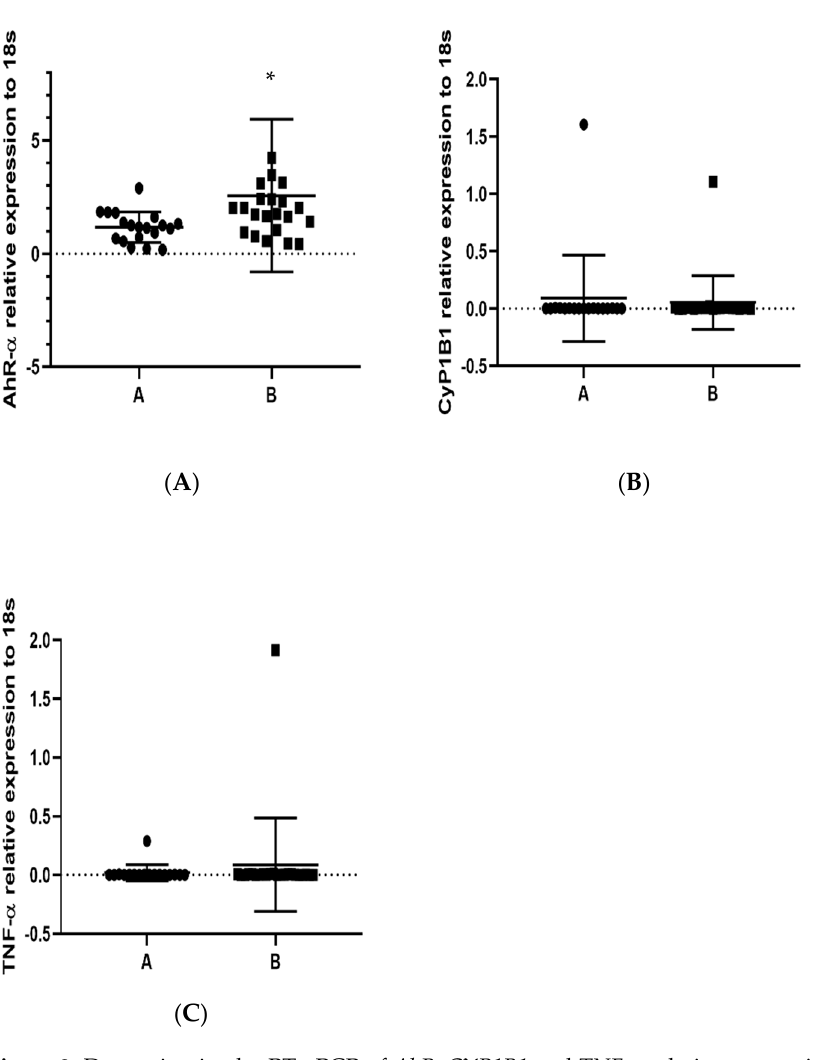
Figure 2. Determination by RT-qPCR of AhR , CYP1B1 and TNF- α relative expression in PBMCs in population (groups A and B) exposed to PAHs: ( A ) AhR , * p = 0.0412; ( B ) CYP1B1 , p = 0.3570; and ( C ) TNF- α , p = 0.2476. 18s RNA was used to normalize the expressed transcripts. * p < 0.05.